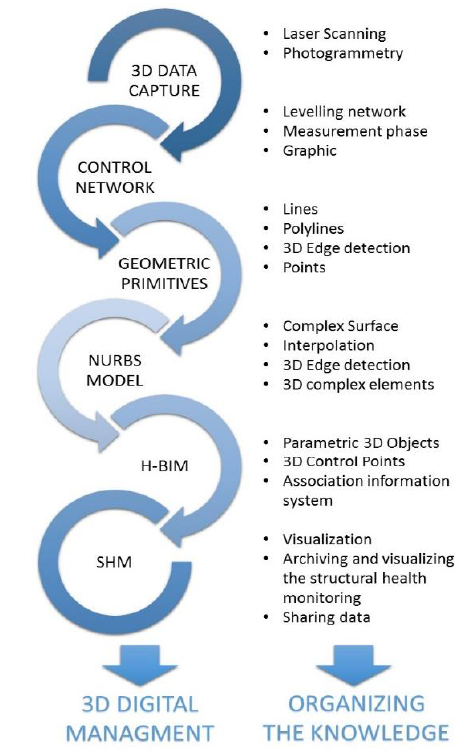
Figure 9. Planning and implementing technology for Human- Centered BIM. The generative process of a historic H-BIM and the system for archiving and visualizing the SHM